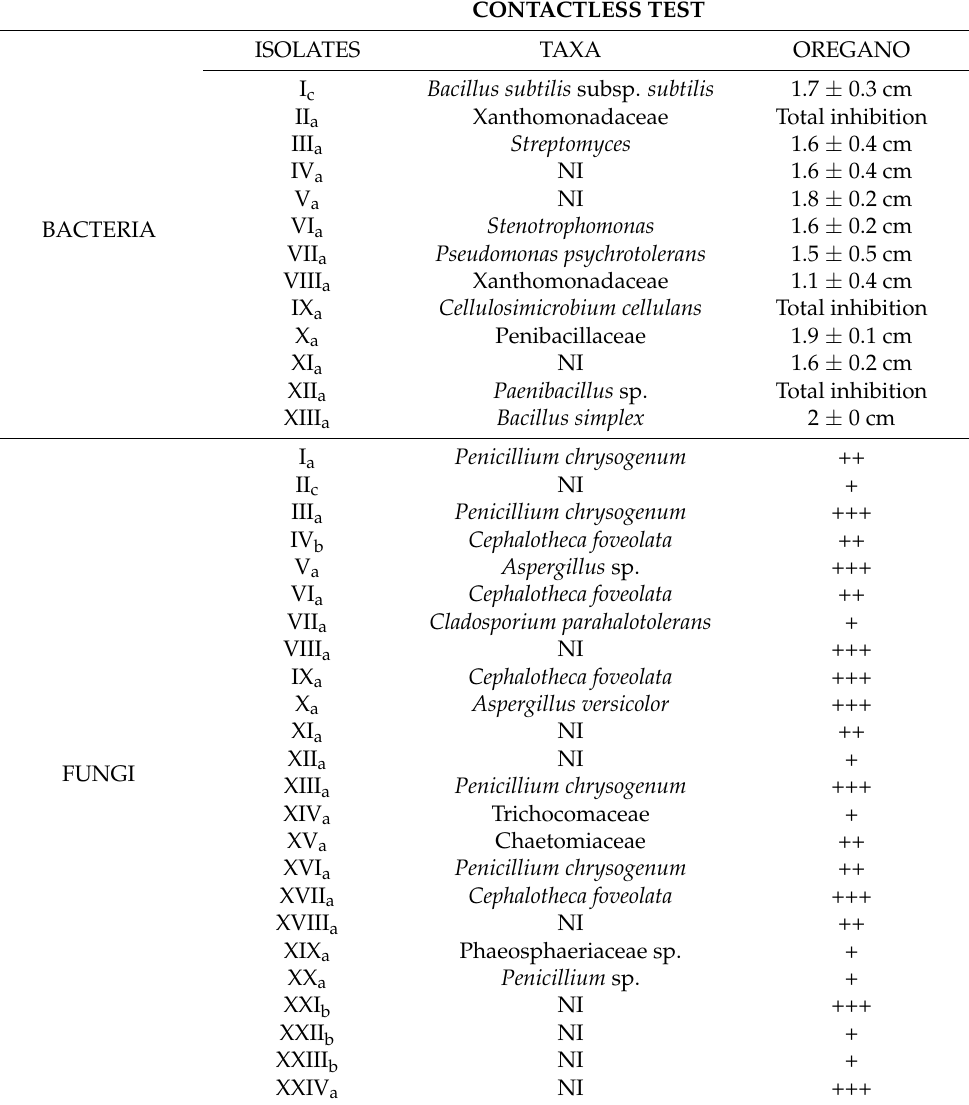
Table 2. Inhibition halo of oregano and cloves essential oils on bacteria and fungi in contactless tests. The experiment was performed in duplicate. NI = not identified strain. Ethanol 70% was used as a negative control as it did not show any inhibitory effect against the